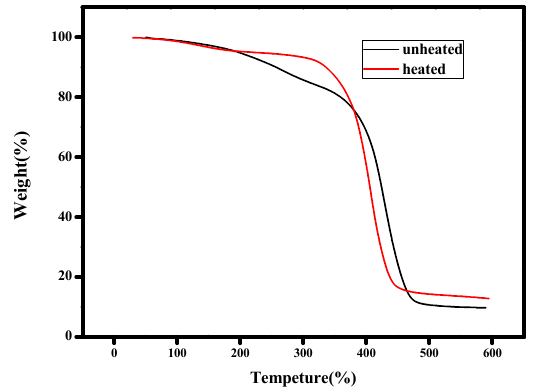
Table 4. TGA data of the hybrid-cured films.